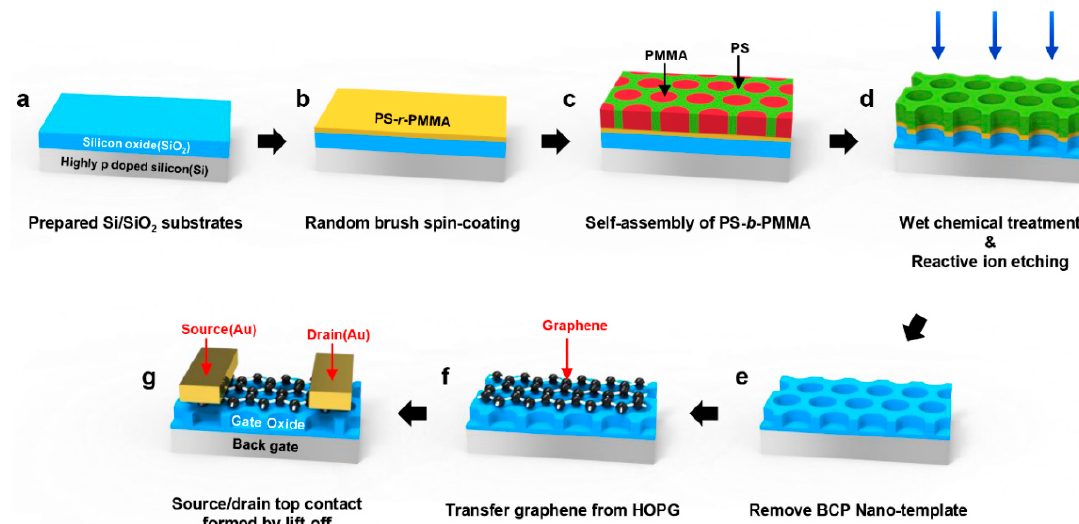
Figure 1. Schematic illustration for the fabrication of partially suspended graphene field-effect transistors (G-FETs) process: ( a ) A silicon oxide wafer is cleaned in sequence with acetone, isopropyl alcohol, and deionized water by sonication. ( b ) A poly(styrene- ran -methyl methacrylate) (PS- r -PMMA) thin film is spin-coated on a silicon oxide substrate and thermally annealed. ( c ) After washing of the un-grafted PS- r -PMMA brush with toluene, a block copolymer (BCP) thin film is spin-coated from solution of the polystyrene- block -poly(methylmethacrylate) (PS- b -PMMA) diblock copolymer in toluene on a silicon oxide substrate and thermally annealed. ( d ) The BCP nanotemplate is treated in sequence with ultraviolet light, acetic acid, and reactive ion etching process to fabricate a nanopore array on silicon oxide substrate. ( e ) The remaining PS block was removed by sonication in toluene for 60 min by 3 times. ( f ) Graphene is transferred onto nanopatterned silicon oxide substrate. ( g ) Source/drain electrodes are formed with Cr/Au layers.